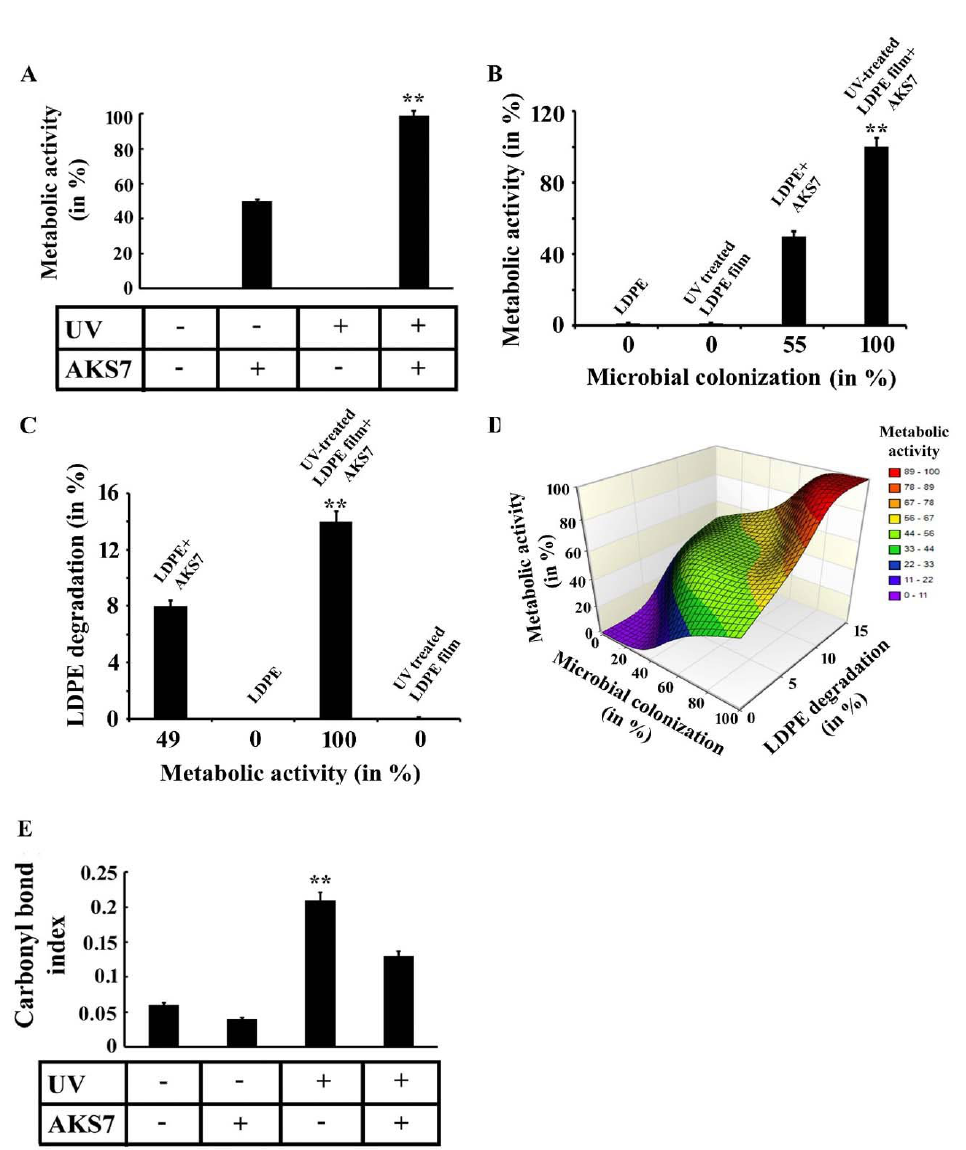
Fig. 6. Enterobacter cloacae AKS7 could colonize and degrade UV-treated LDPE film more efficiently than UV- untreated LDPE film. An equal number of AKS7 was added to the sterile basal media in which either UV-treated or untreated LDPE films were independently added. All the growth media were then incubated at 30°C for 30 days. After the incubation, each type of LDPE film was recovered from the growth media. A. Metabolic activity of the microorganisms adhered to the LDPE films was determined by FDA hydrolysis assay. B. Plot of microbial colonization vs metabolic activity of the colonized cells. C. Plot of metabolic activity vs. LDPE degradation by AKS7. Each experiment was performed thrice. Error bars indicated mean ± standard error of the mean. Statistical analysis was performed using ANOVA and the P-value <0.01 (marked with **) was considered to express the significant difference among the results. D. Relation among microbial colonization, metabolic activity, and LDPE degradation was established by constructing a surface plot. E. Carbonyl bond index of different types of LDPE films was analyzed using an FTIR spectrophotometer. Each experiment was performed thrice. Error bars indicated mean ± standard error of the mean. Statistical analysis was performed using ANOVA and the P-value <0.01 (marked with **) were considered to express the significant difference among the